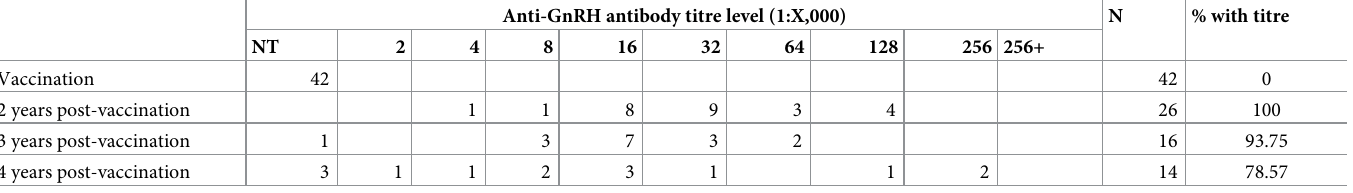
Animals were treated with a primer vaccination and a booster dose of GonaCon in 2015. NT = no detectable titre; N = sample